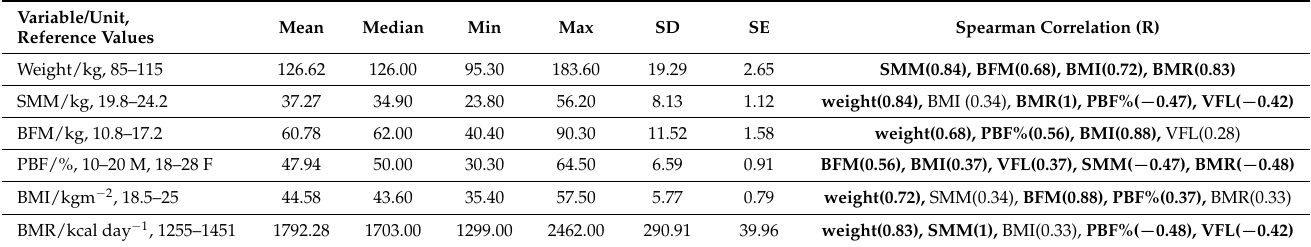
Table 1. Anthropometric parameters of the entire group (n = 53) with BMI ≥ 35 kgm −